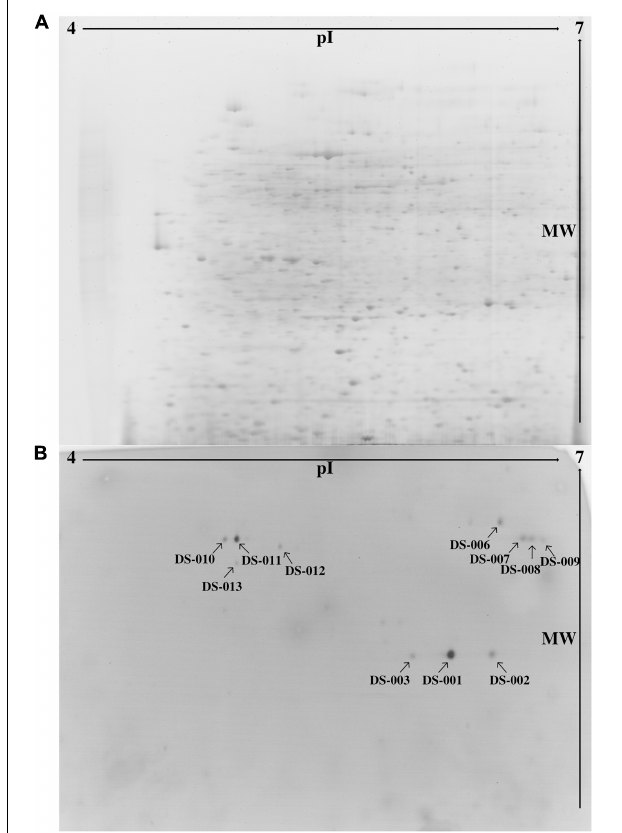
FIGURE 1 | (A) Protein extract from an enrichment culture of sediment from Bakreshwar hot spring (located in West Bengal, India) was separated in a 2D gel and stained with RuBPS Protein Gel Stain. (B) 2D PAGE zymography was carried out to detect protein spots showing lipolytic activity. Present lipolytic enzymes in the gel hydrolyzed the fluorogenic substrate pMUB. The blue fluorescent p -methylumbelliferone was detected under ultraviolet light. Spot DS-007 could be identified by mass-spectrometry (spots marked with an